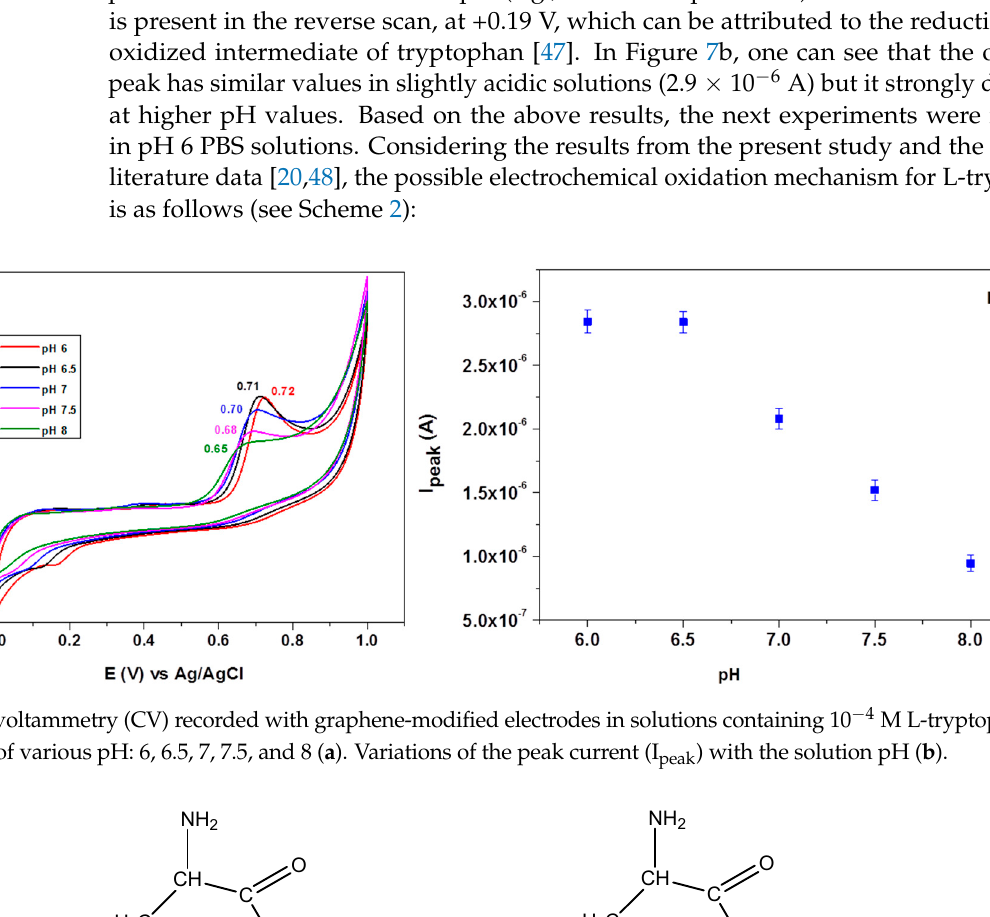
Figure 7. Cyclic voltammetry (CV) recorded with graphene-modified electrodes in solutions containing 10 − 4 M L-tryptophan in PBS solutions of various pH: 6, 6.5, 7, 7.5, and 8 ( a ). Variations of the peak current (I peak ) with the solution pH ( b ).